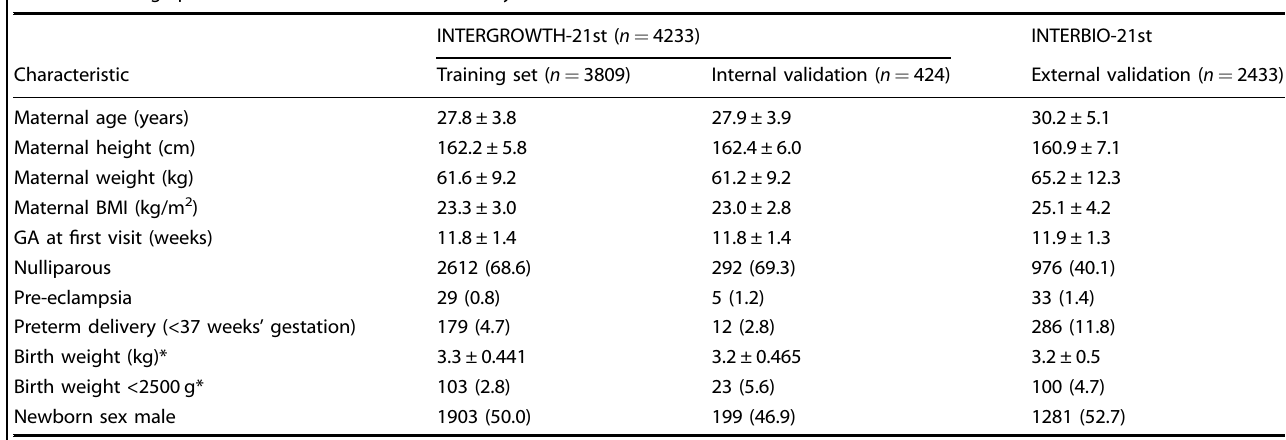
Table 1. Demographics of women included in this study.